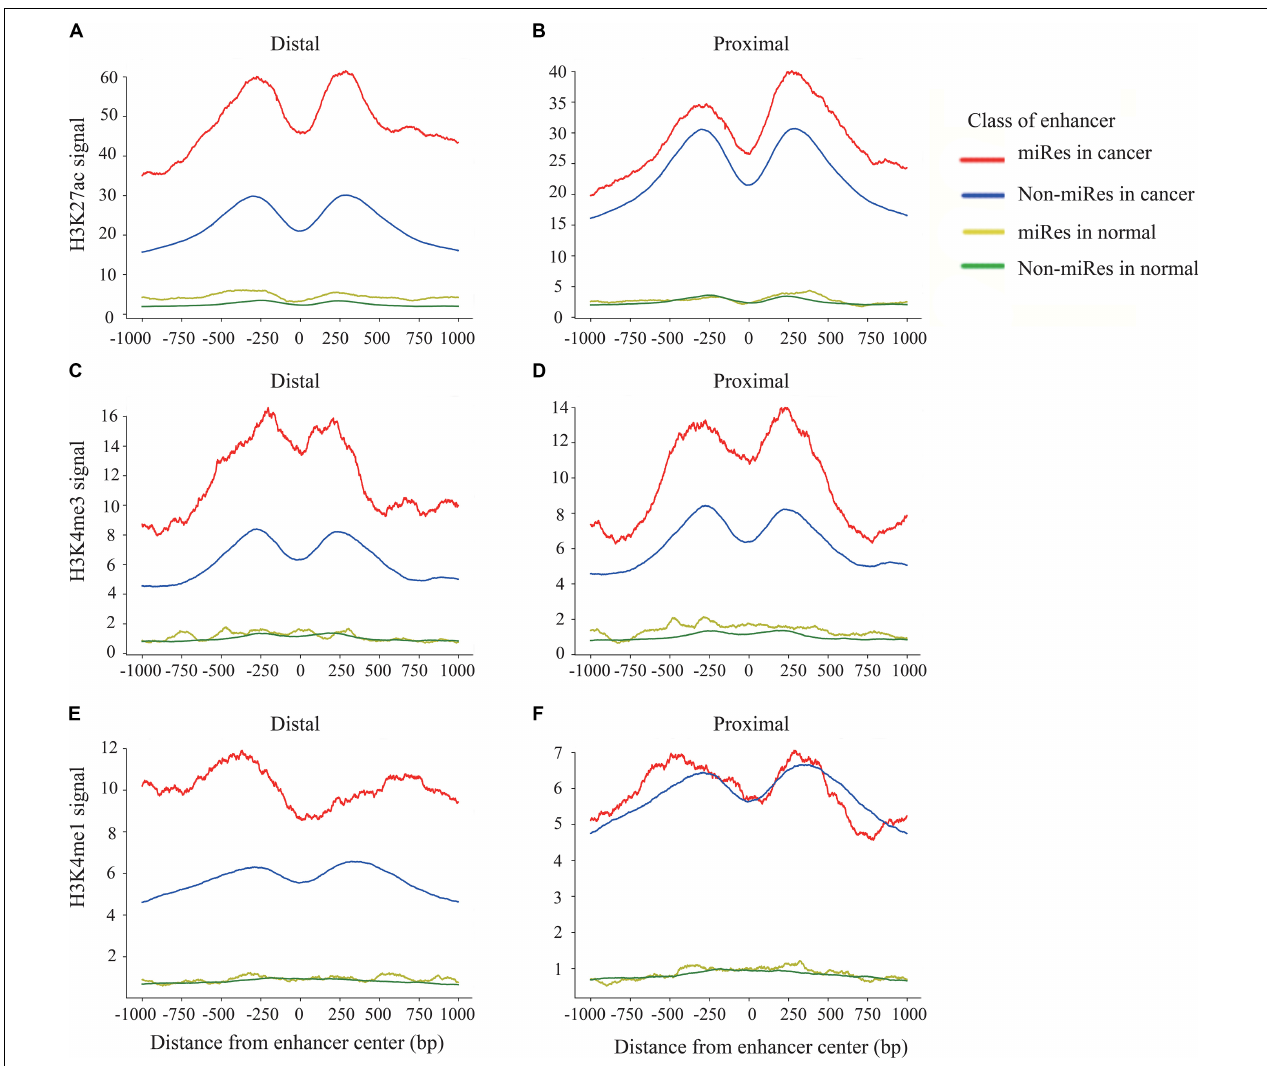
FIGURE 4 | Signal of H3k27ac within ± 1 kb surrounding the center of the enhancer in distal regulation (A) and proximal regulation (B) . Signal of H3k4me3 within ± 1 kb surrounding the center of the enhancer in distal regulation (C) and proximal regulation (D) . Signal of H3k4me1 within ± 1 kb surrounding the center of the enhancer in distal regulation (E) and proximal regulation (F)